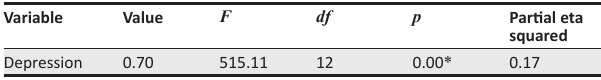
TABLE 5 : MANOVA – Differences in work engagement, burnout and stress- related ill health levels of depression groups.